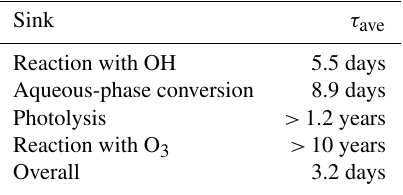
Table 4. Estimated global average carbon suboxide lifetimes τ ave from model simulations, for each process separately and for all loss processes combined.